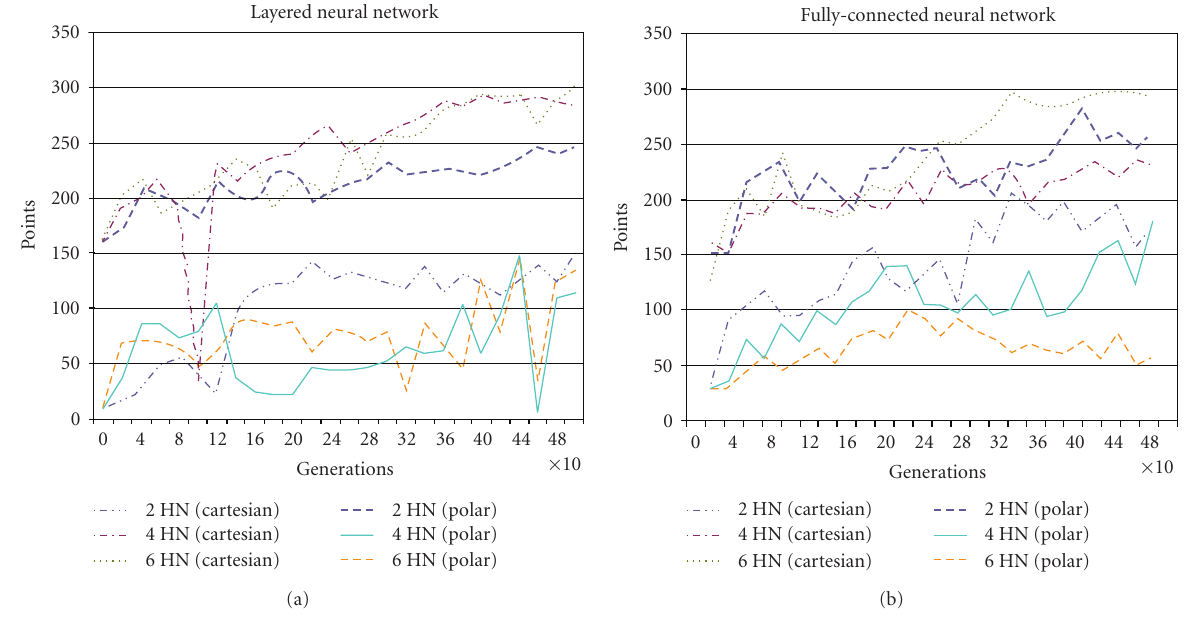
Figure 6: Tournament results of ANN with di ff erent I/O interfaces.